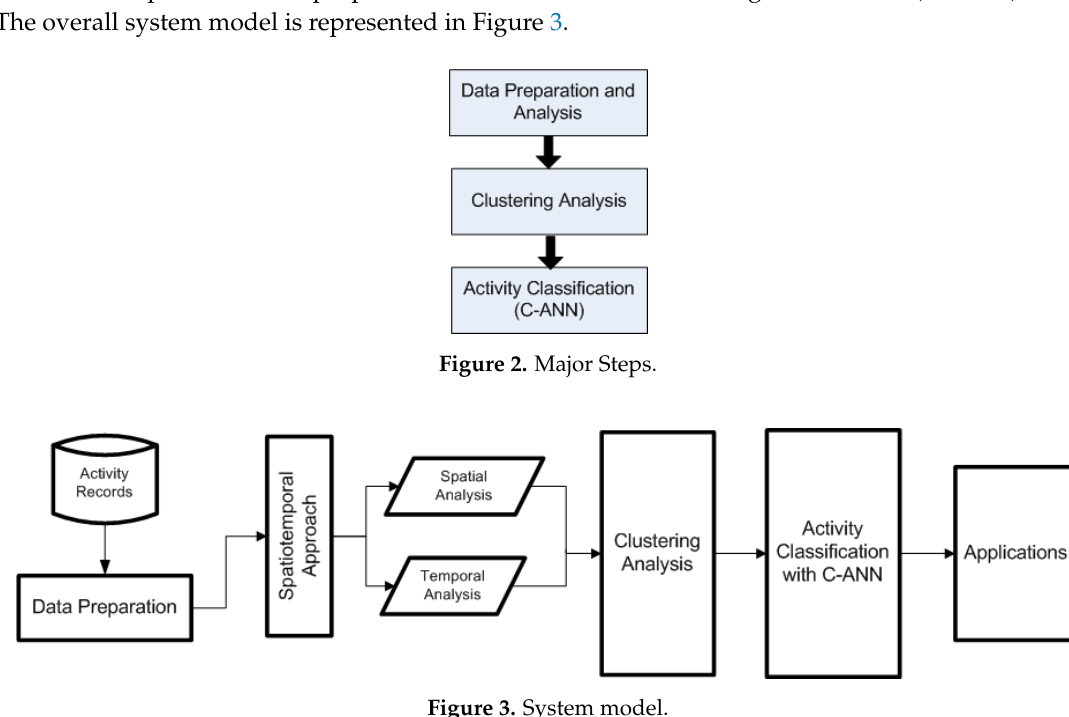
Figure 3. System model.